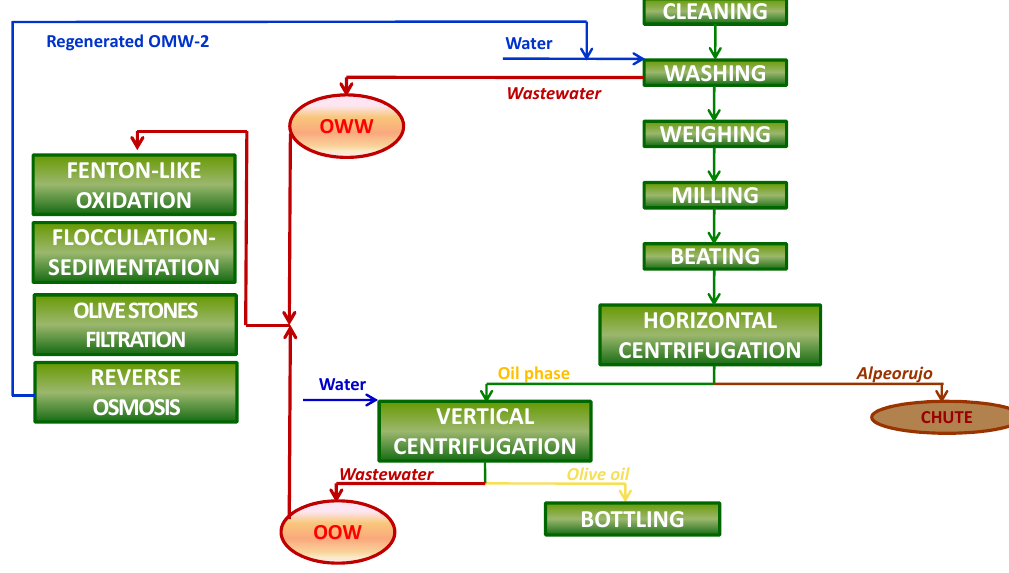
Figure 5. Integrated olive oil production process.